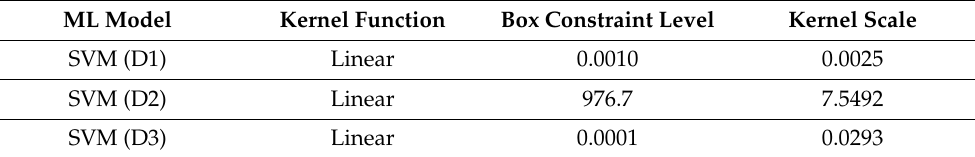
Table A5. Support Vector Machine: optimized hyperparameters for each dataset.